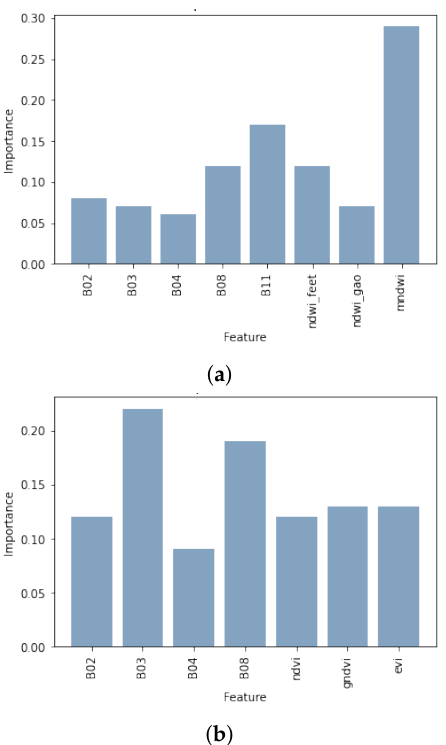
Figure 6. Feature importance. ( a ) Feature importance in CLAML-M model for flooding. ( b ) Feature importance in CLAML-M model for